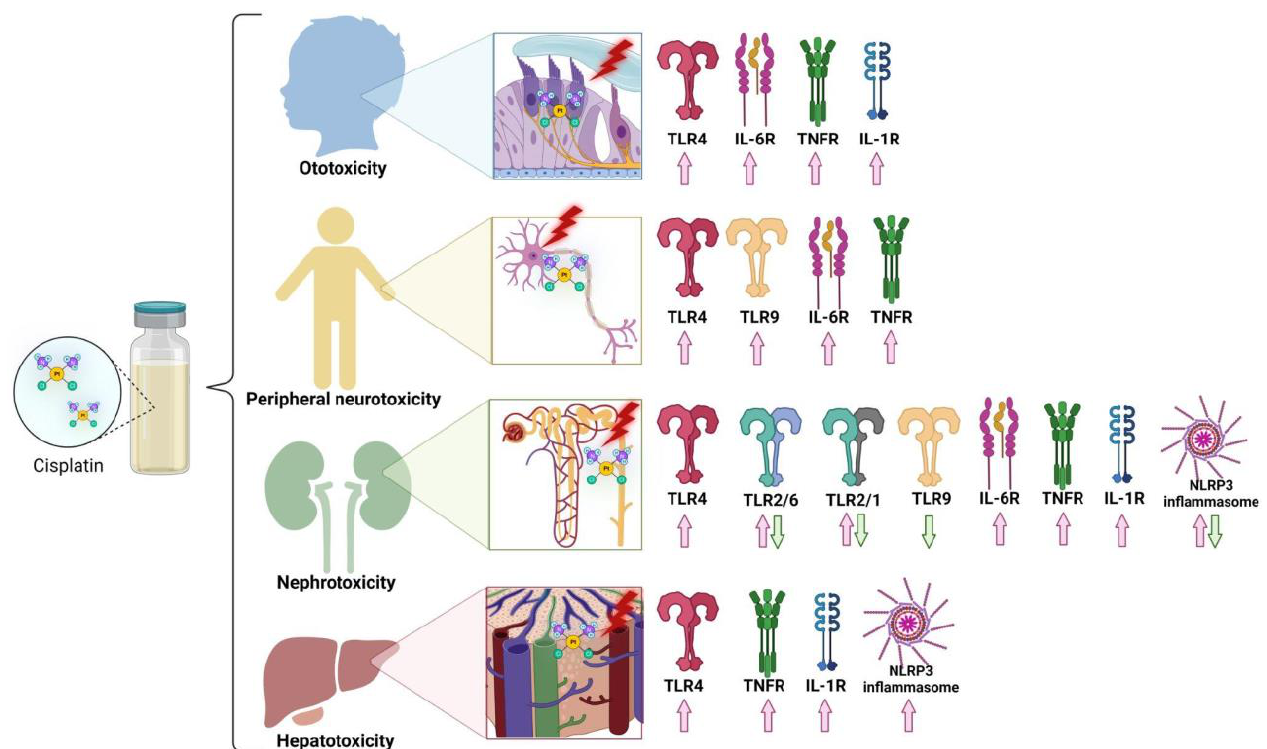
Figure 3. Summary of reported innate immune receptors involved in cisplatin-induced ototoxicity, peripheral neurotoxicity, nephrotoxicity, or hepatotoxicity. The depicted innate immune receptors are involved in either protecting (green arrow) or exacerbating (red arrow) inflammation in response to systemically delivered cisplatin, and a few key receptors have been reported in both cases.